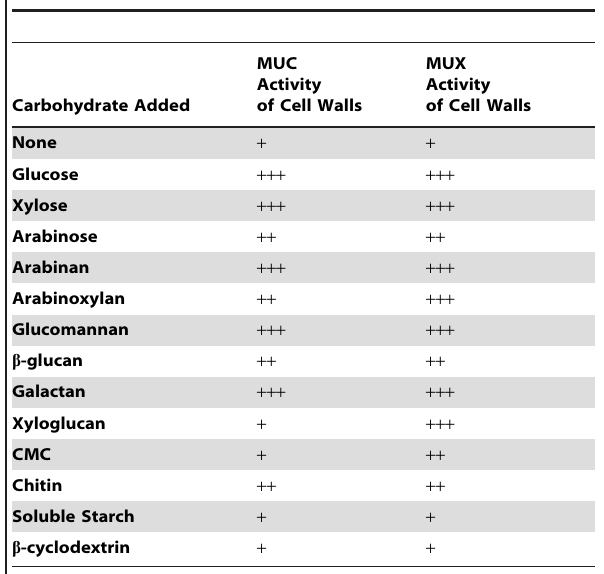
Table 10. Activity of Cell Wall Fractions from Cultures Grown on Different Carbohydrates.